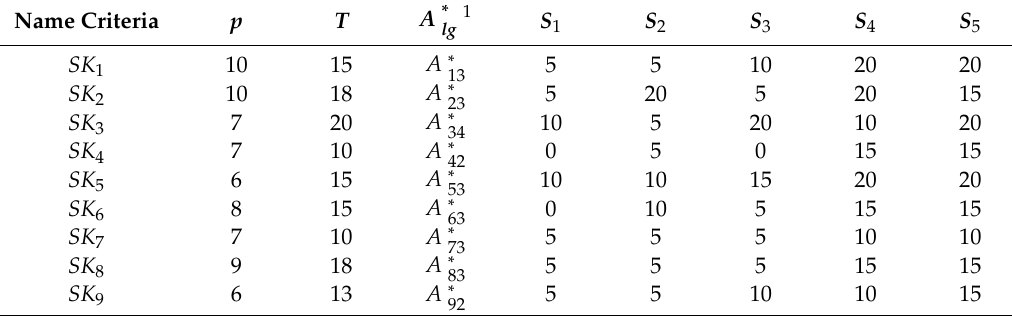
Table 2. Input of environmental start-up projects on the criteria of evaluation.